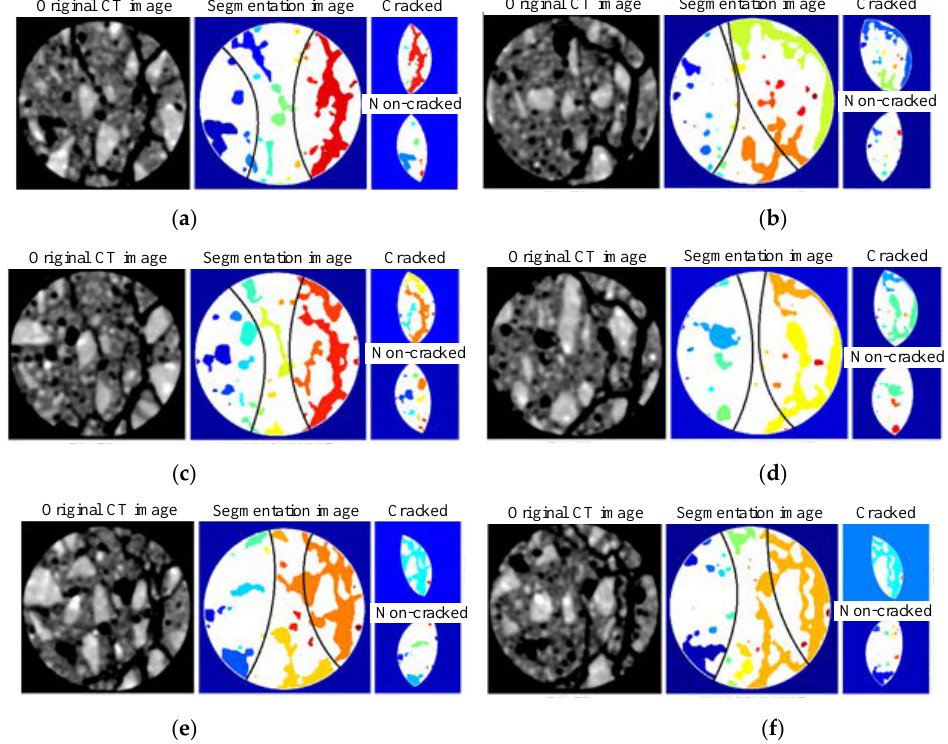
Figure 9. The partitioning results of cracked zone and no-cracked zone, ( a ) S120, ( b ) S130, ( c ) S140, ( d ) S150, ( e ) S160, ( f ) S170.